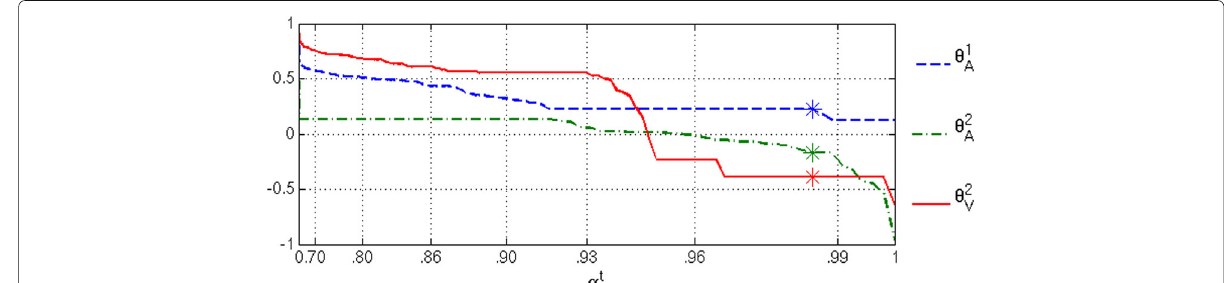
(cid:10) (cid:11) = θ 1 , θ 2 , θ 2 , t = 0 ... T found by the proposed BOATS algorithm for a BOA (14) with A A V t t